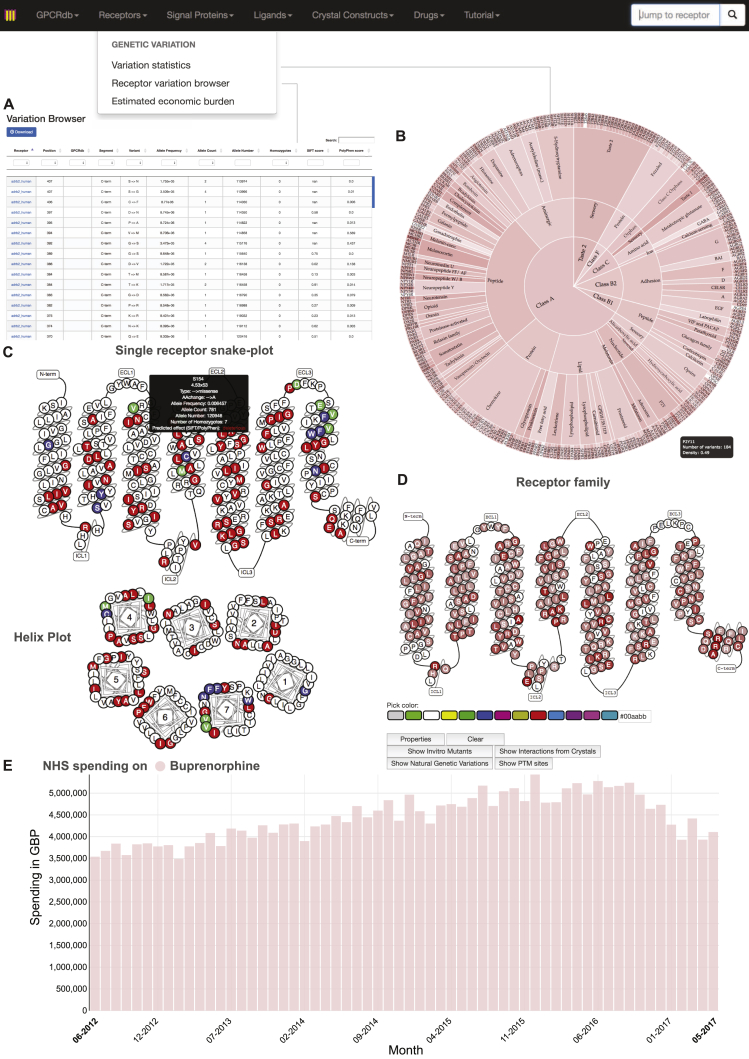
Resource and Tools for the Analysis of Variation Data of GPCR Drug Targets within GPCRdb, Related to Figure 6Datasets for natural genetic variations comprising of 60,706 individuals have been integrated into the GPCRdb.(A) Sortable variant table is provided for every receptor with more detailed information on the type and nature of each amino acid substitution, information about allele counts and frequency, predicted functional impact scores (SIFT and PolyPhen) and functional site annotation.(B) Genetic variation density (red intensity levels) on a GPCR classification tree (item ‘statistics’).(C) Data points can be visualized for every selected non-olfactory GPCR (missense variants in red shown for adrb2_human) on a snake-like diagram (top) or a helix plot (bottom) with additional information shown on mouse-over (allele count, allele frequency, amino acid change, number of homozygotes, predicted effects by SIFT and PolyPhen).(D) Missense variants can also be visualized on a consensus snake-like diagram for single families or ligand-types of GPCRs (gradient red for all Class A peptide angiotensin receptors). Each position then gives the number of observed mutations and the list of observed amino acid changes.(E) National Health Service spending data from 2011 to 2017 for 279 FDA-approved drugs. This is shown for Buprenorphine. The natural variation dataset can be downloaded per receptor (www.gpcrdb.org/mutational_landscape/) or accessed programmatically via an extensive API.